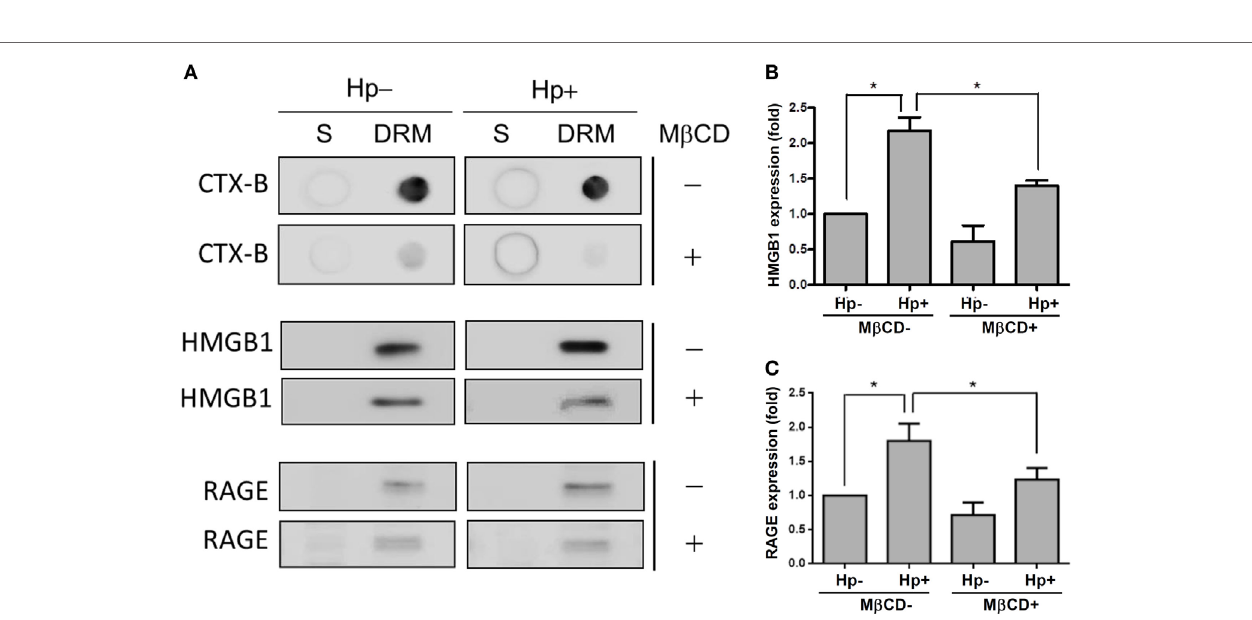
FigUre 7 | role of cholesterol-rich microdomains in H. pylori -induced hMgB1 and rage expression . AGS cells were untreated or pretreated with 5 mM M β CD at 37°C for 1 h. Cells were then washed and infected with H. pylori at an MOI of 100 for 6 h. (a) Detergent-resistant membrane (DRM) and detergent-soluble (S) fractions were prepared and subjected to cold detergent extraction using 1% Triton X-100 at 4°C followed by centrifugation. Each fraction was analyzed by dot blot or Western blot using cholera toxin subunit B (CTX-B) conjugated to horseradish peroxidase or antibodies against HMGB1 and RAGE, respectively. Protein expression levels of (B) HMGB1 and (c) RAGE were quantified by densitometric analysis (* P <